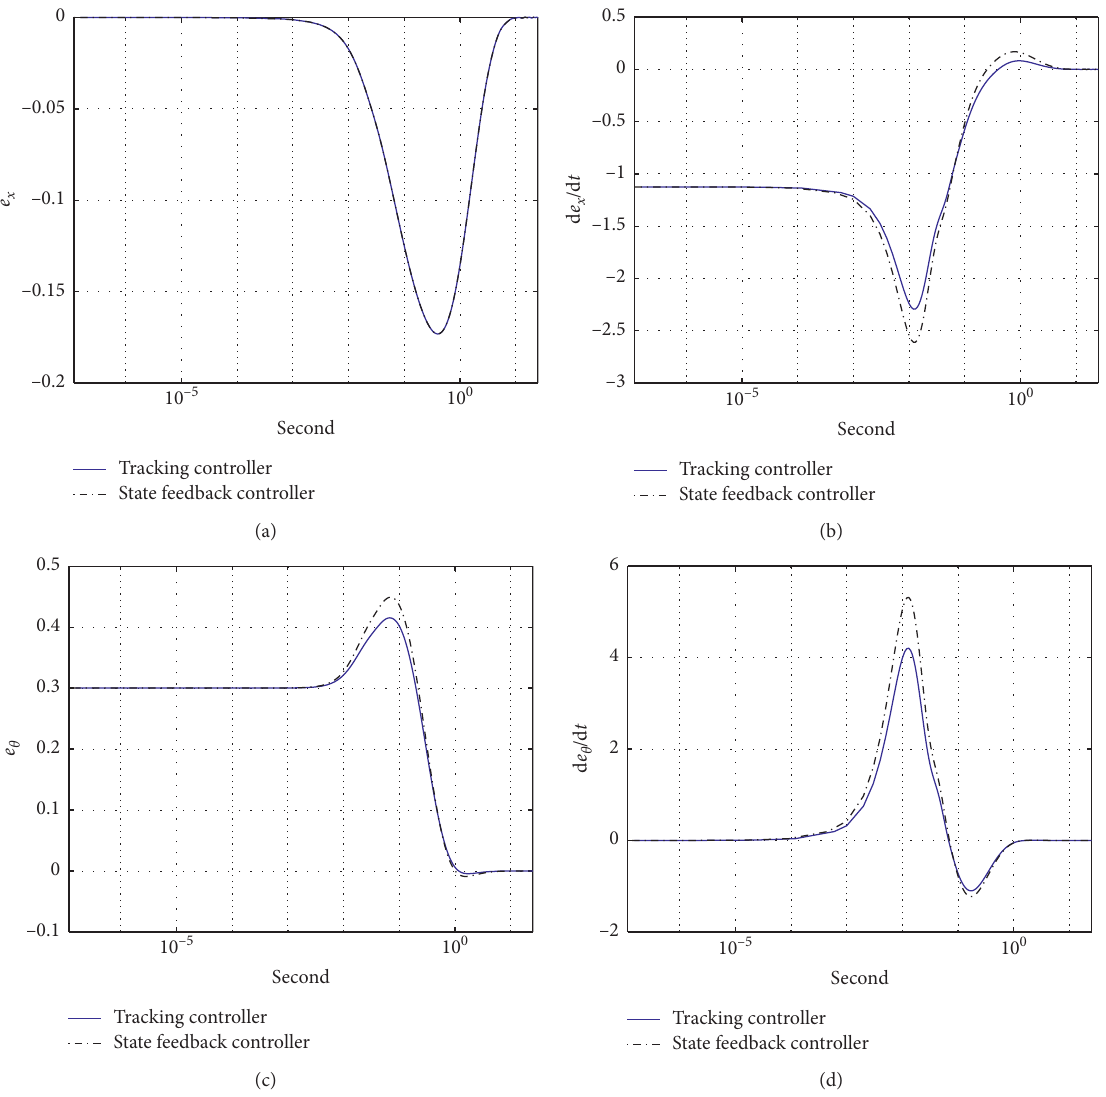
Figure 5: Comparisons on x , _ x , θ , and _ θ . (a) Position error. (b) Error of tilt angle. (c) Error of longitudinal velocity. (d) Velocity error of